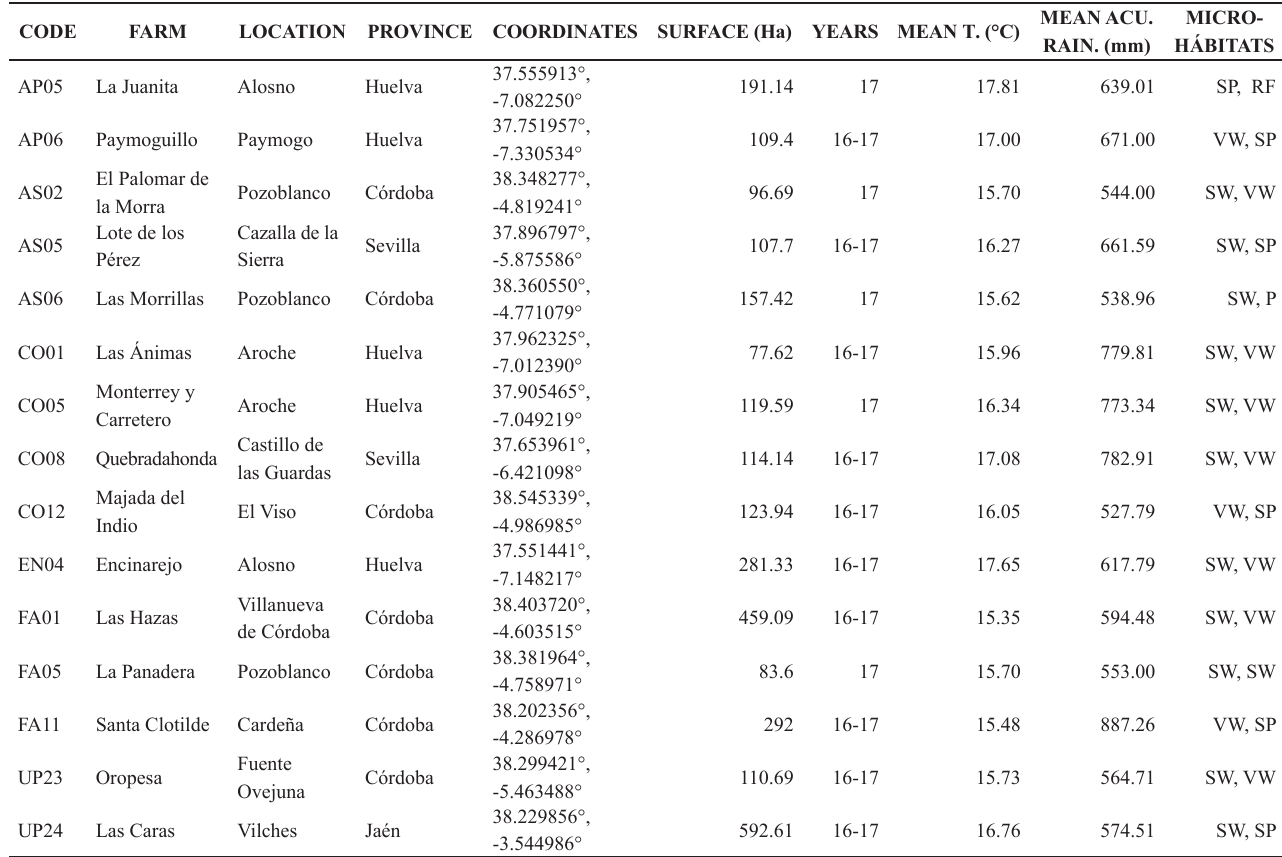
Table 1 . Codes for the study farms, their location, surface and years of sampling. Five farms were full sampled in 2017 (‘dehesas’ and microhabitats). In the rest of the farms the ‘dehesas’ were sampled in 2016 and the microhabitats in 2017. Means of annual temperatures (MEAN T.) and means of accumulated rainfall (MEAN ACU. RAIN.) are included. Microhabitats column shows the different types of microhabitats sampled per farm: zones adjacent to traditional stone walls (SW); scrub patches (SP); vegetation of temporary water courses (VW); ponds (P); riparian forest